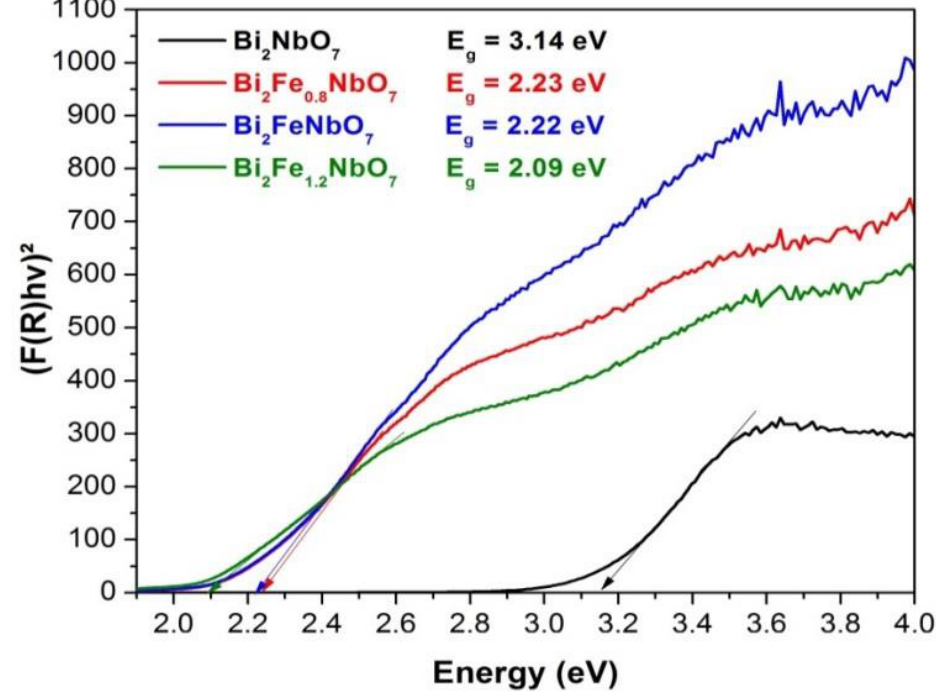
Figure 5. Band gap estimation of Bi 2 Fe x NbO 7 photocatalysts.